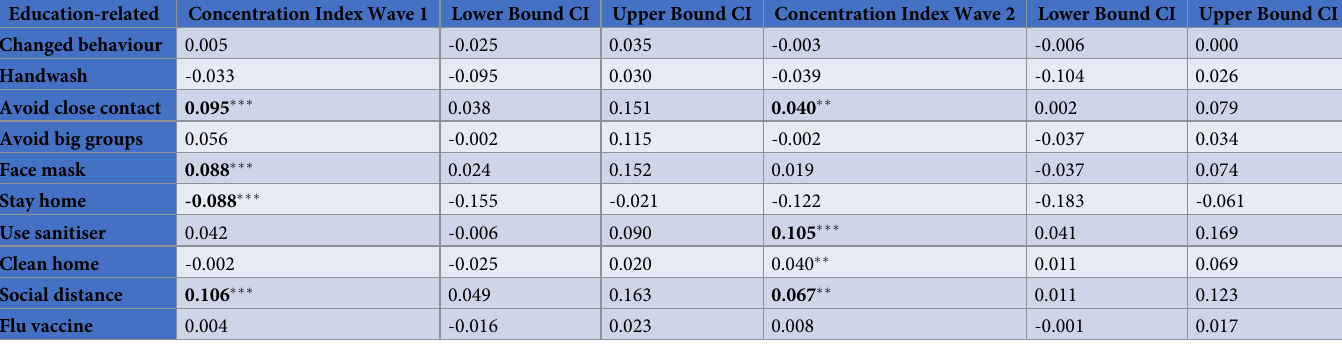
Table 3. Erreygers’-corrected concentration index (education-related) of preventive measures. Education-related